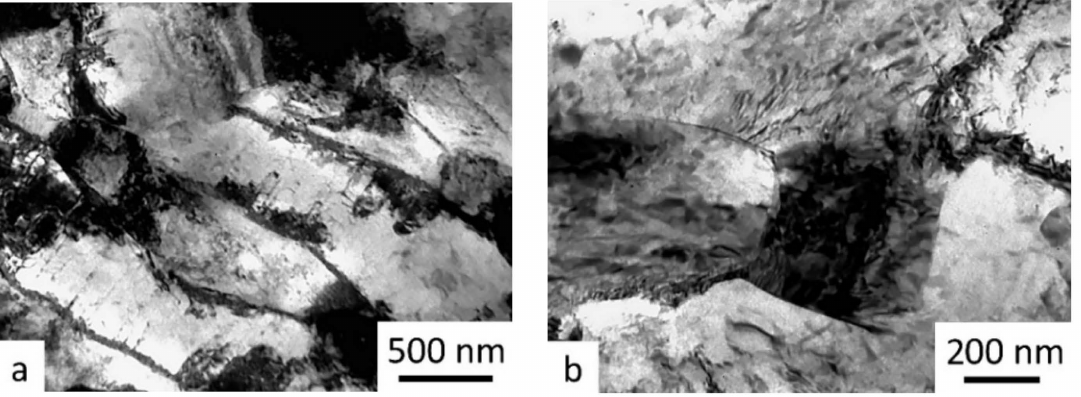
Figure 7. TEM images of the microstructure of the Ti-6Al-4V alloy samples in the UFG state after fatigue tests at a stress of 900 MPa: dislocation pile-ups at grain boundaries ( a ) and triple junctions ( b